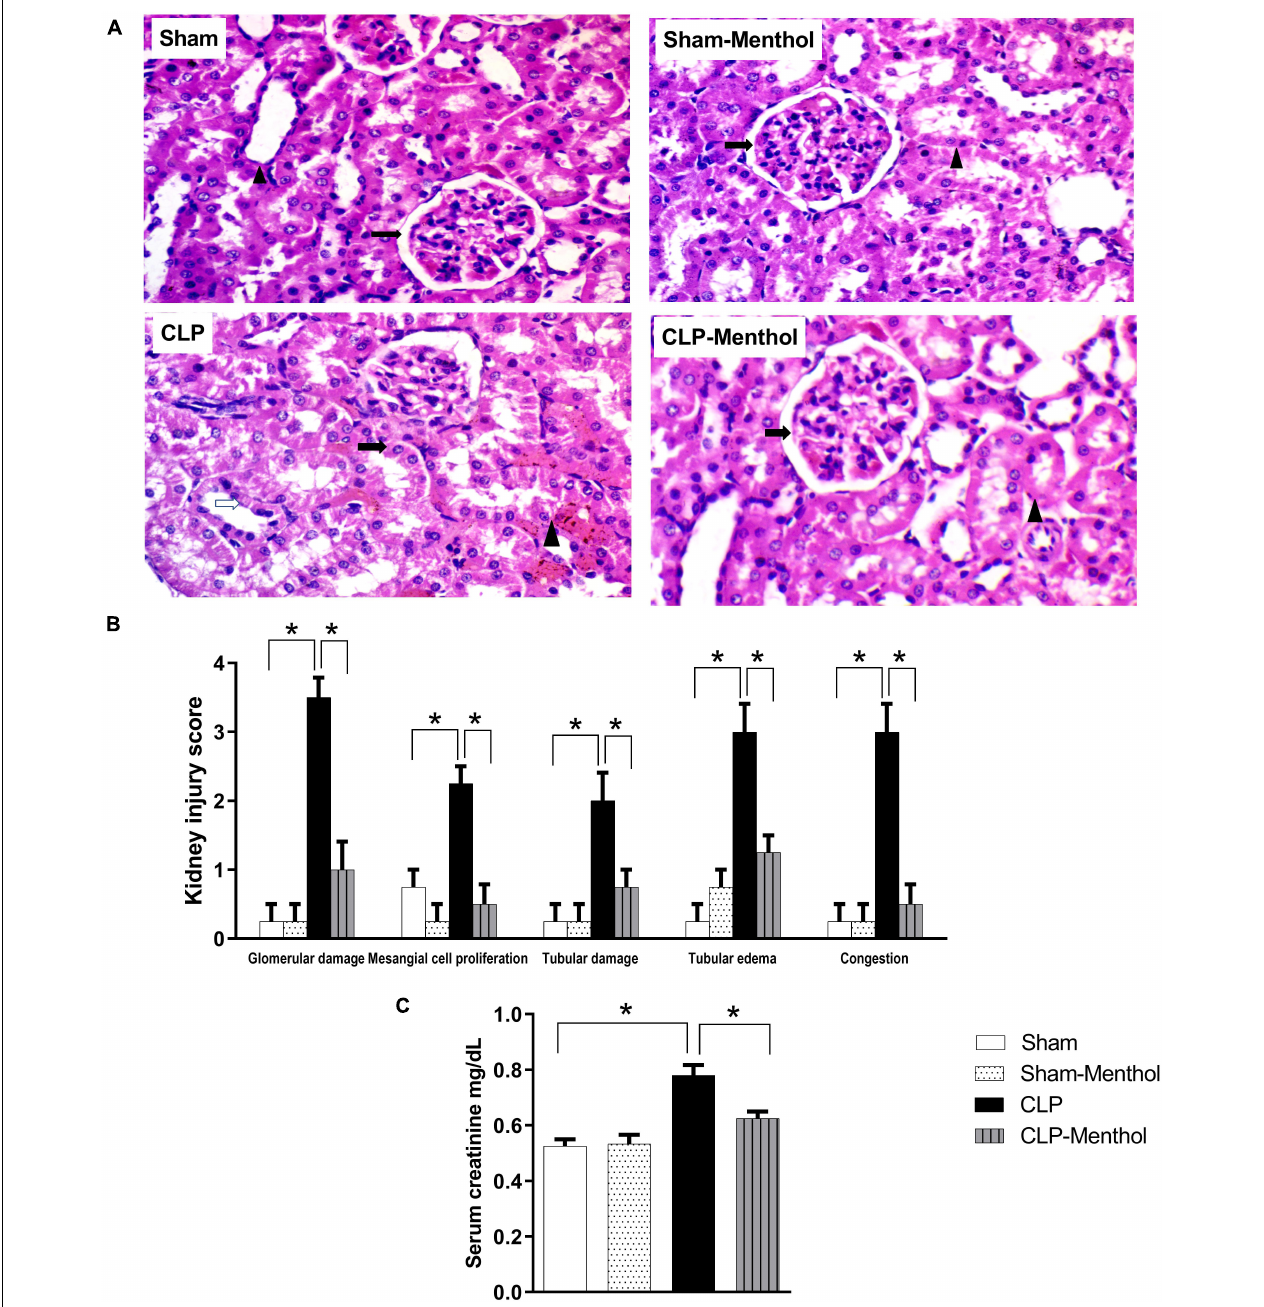
FIGURE 3 | Effect of menthol treatment on sepsis-induced acute kidney injury. Sepsis was induced by CLP under general anesthesia as described under the “Materials and Methods” section. Animals were killed after 24 h of CLP and the kidney injury was assessed by histological examination of H&E-stained (200X) 5 µ m sections (A,B) and by determination of serum creatinine concentration (C) in all groups ( n = 6 per group). (A) Representative photomicrographs showing that menthol treatment attenuated the histopathological changes induced by sepsis in kidney tissues (H&E stain, 200X). The sham groups (Sham and Sham-Menthol) showed normal histological appearance with normal interstitial tissue without congestion or inflammatory cell infiltration. The glomeruli of the vehicle-treated CLP group (CLP) showed moderate damage and obliterated Bowman’s spaces. These sections showed proliferated mesangial cells (arrow) surrounded by tubules with focal areas of tubular damage (white arrow), tubular edema, compressed intratubular vascular spaces (arrowhead) and congested interstitial tissue. Menthol treated group showed renal glomerulus with normal histological appearance (arrow) surrounded by tubules (arrowhead) with normal interstitial tissue without congestion or inflammatory infiltrates. (B) Bar charts showing analysis of the mean values of combined kidney injury scores (at least 10 fields per section from 6 animals per group). (C) Bar graph showing the serum creatinine data from the different groups. All data represent the mean ± SEM of 6 independent observations. Data were analyzed by one-way ANOVA followed by the Tukey-Kramer post- test for multiple comparisons. *Significantly different at p < 0.05 compared to the CLP group.